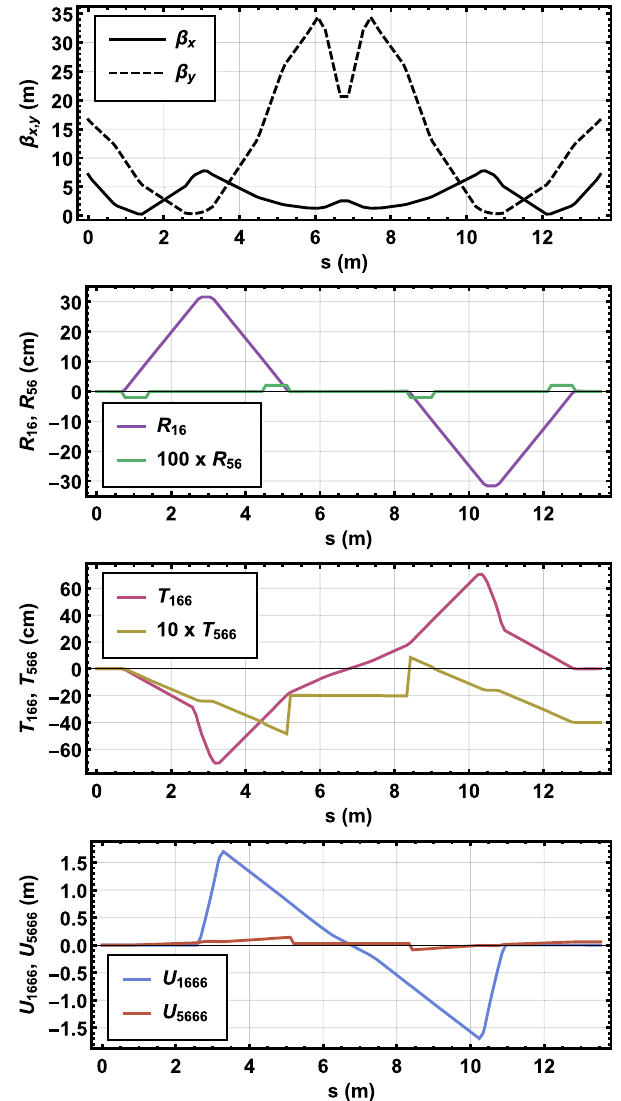
FIG. 14. Optics and first-, second- and third-order dispersion functions of isochronous MAX IV BC1 with additional dipoles.